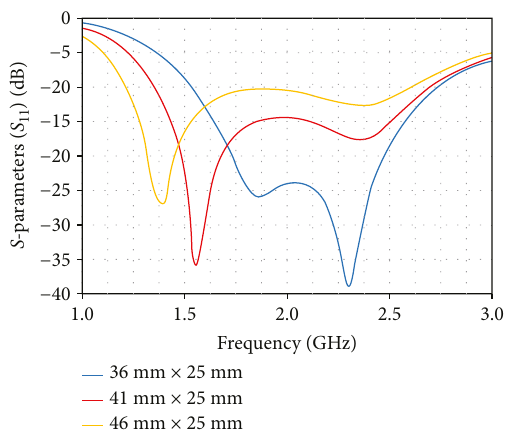
Figure 6: Simulated and measured S -parameters: S antenna.